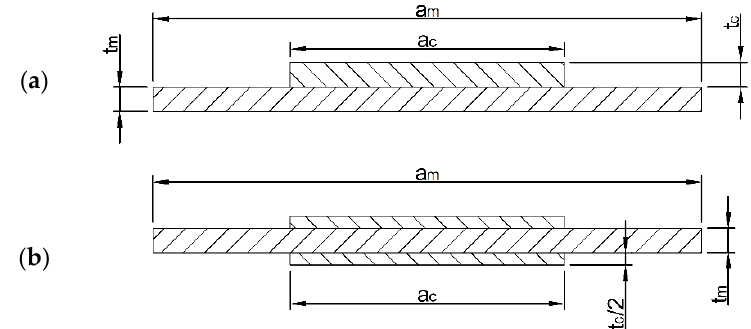
Figure 3. Single-sided ( a ) and double-sided ( b ) patch configuration.